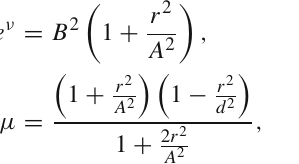
Fig. 1 Energy density ˜ ρ for M = 0 . 2, R = 1, c 1 = 0 . 5 and